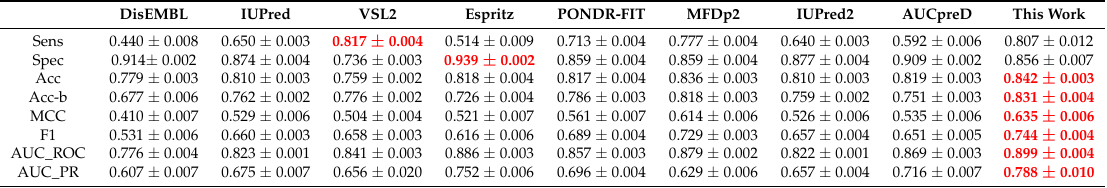
Table 1. Prediction performance of the new strategy under five-fold cross-validation, in comparison with four component predictors, another four recently-designed predictors.